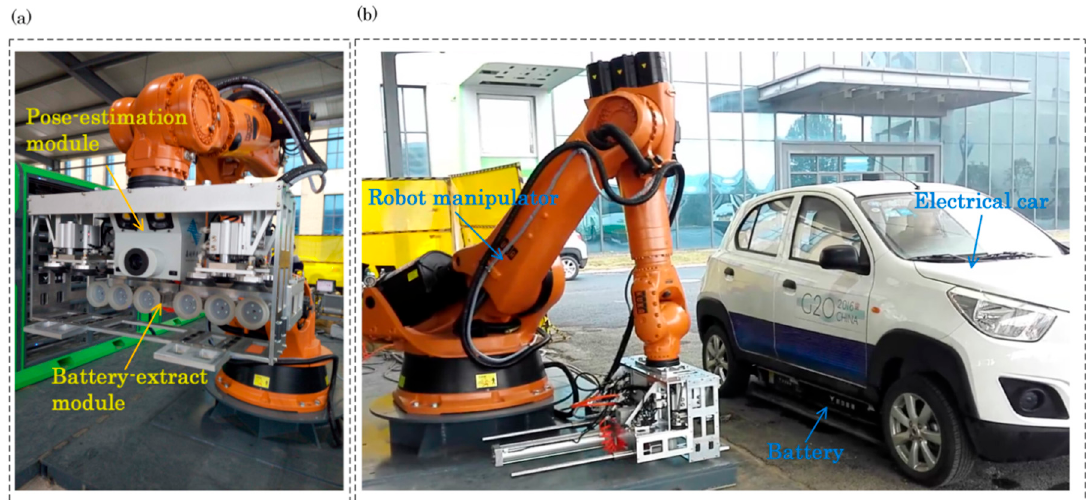
Figure 9. ( a ) The pose-estimation module and battery-extract module are mounted onto the KUKA robot manipulator, the suction cup is used to pull the battery out of the electric automobile; ( b ) The scene of automatic battery-replacement process.